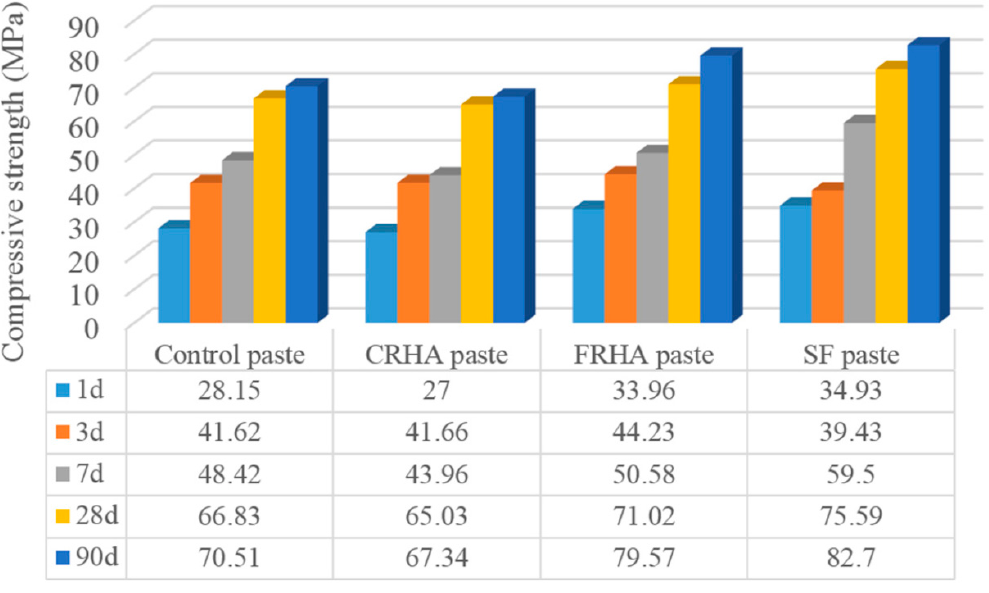
Figure 8. Compressive strength of studied pastes [83].